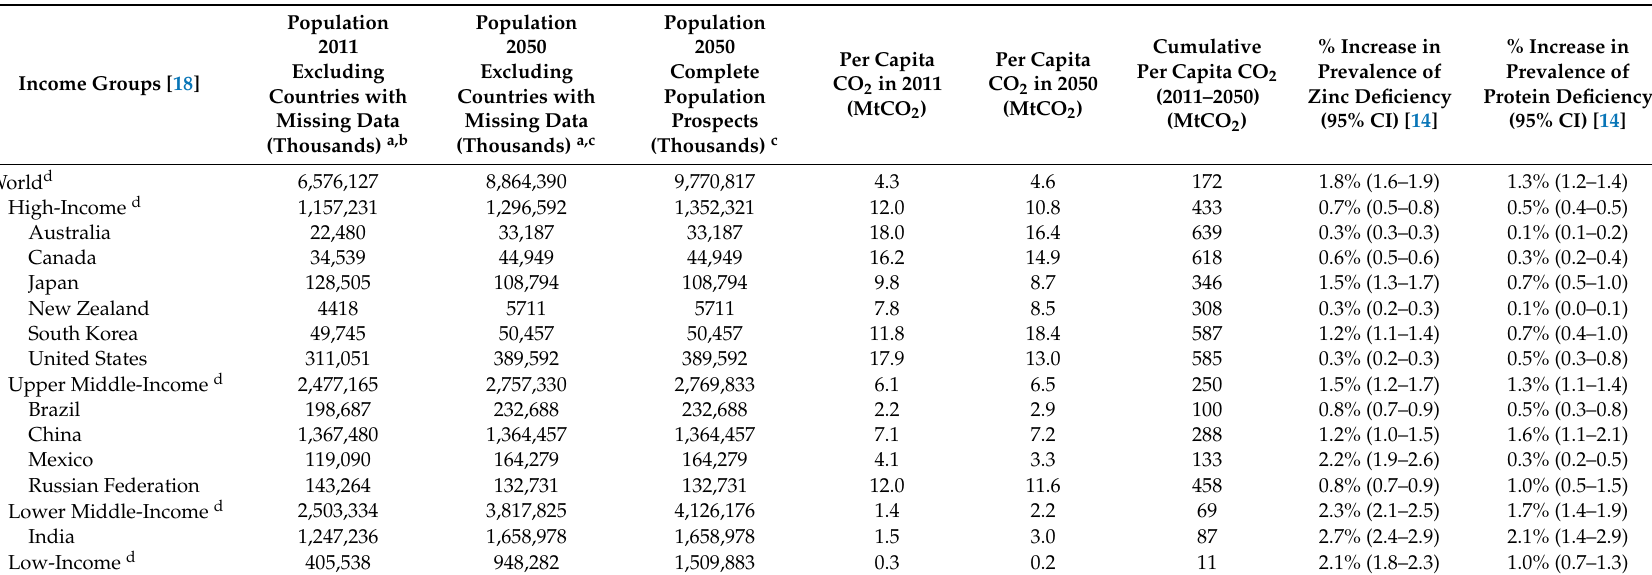
Table 1. Populations, cumulative per capita CO 2 emissions, and increased population at risk of zinc and protein deficiency resulting from elevated CO 2 between 2011 and 2050, by income